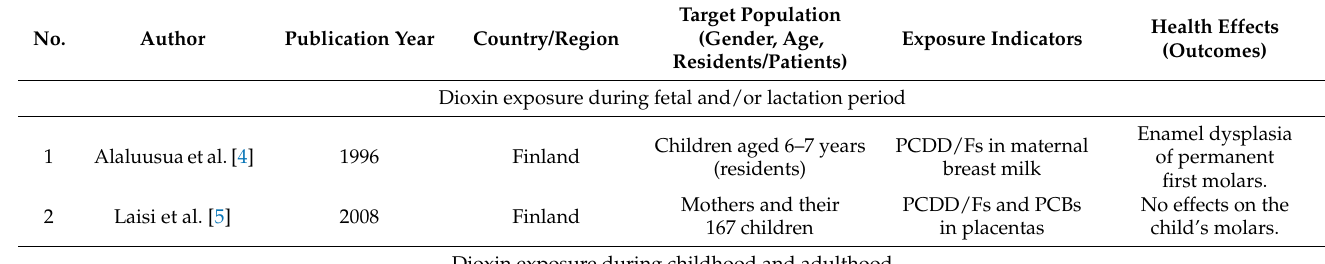
Table 2. Effects of dioxins and PCBs on teeth in